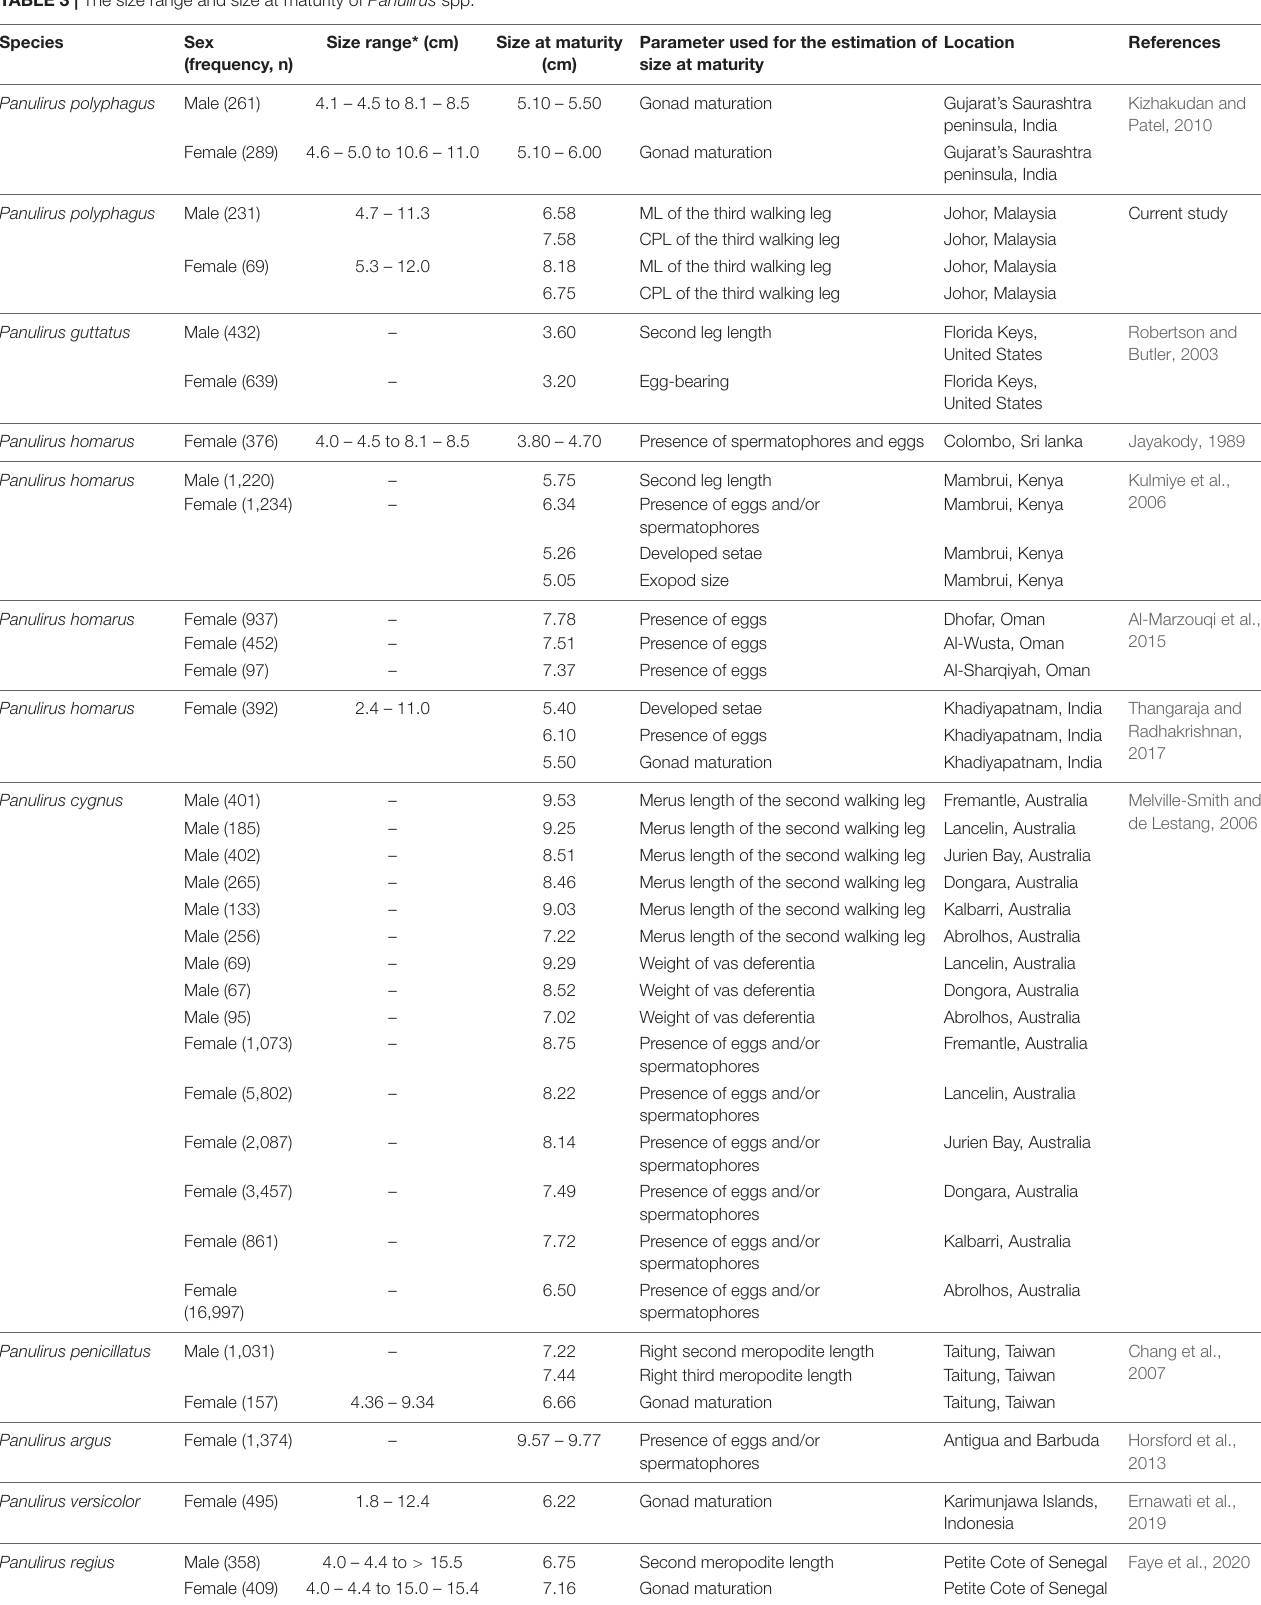
TABLE 3 | The size range and size at maturity of Panulirus